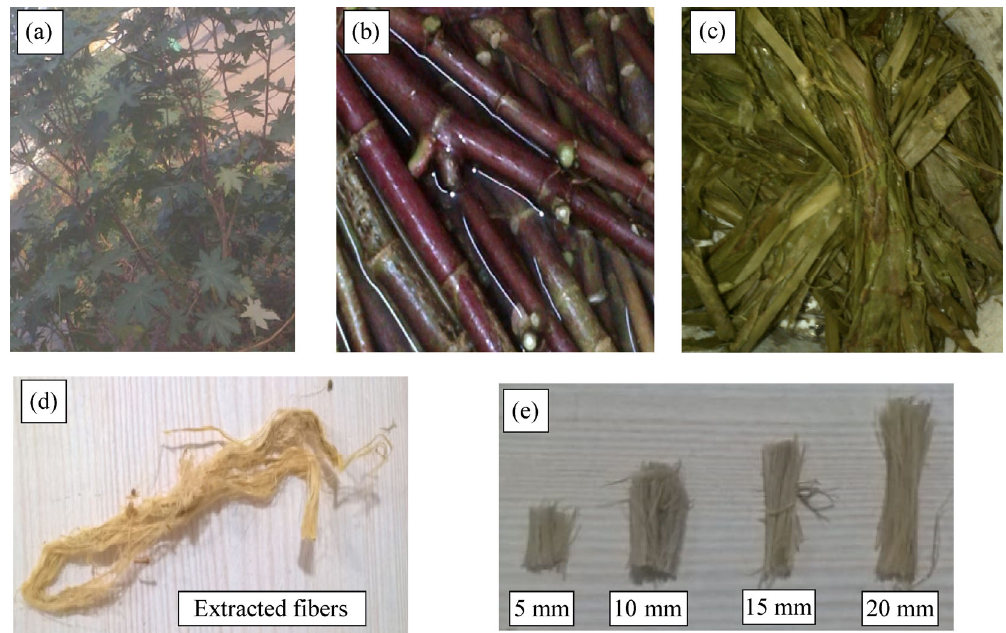
Fig. 1 Fiber extraction procedure. (a) Castor oil plant, (b) stems immersed in water, (c) stems after immersion, (d) extracted fibers, and (e) chopped